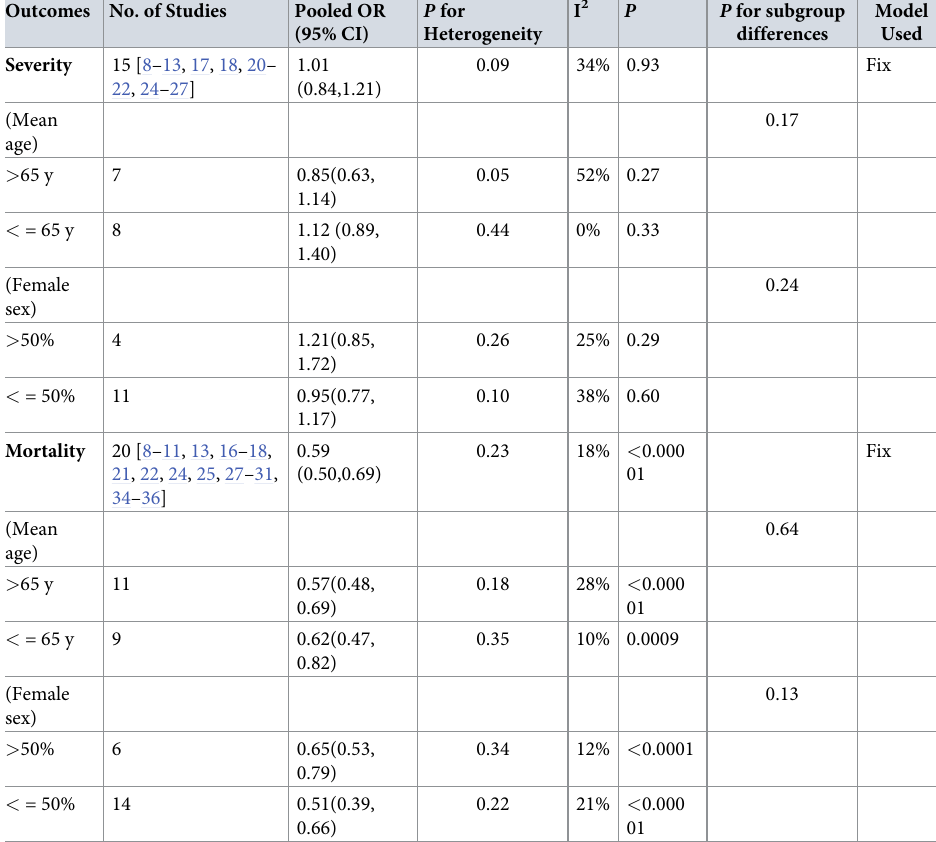
Table 3. Clinical outcomes of East-Asian Covid-19 patients treated with ACEI/ARB vs. untreated subjects (HT subgroup). Outcomes No. of Studies Pooled OR P for (95% CI)